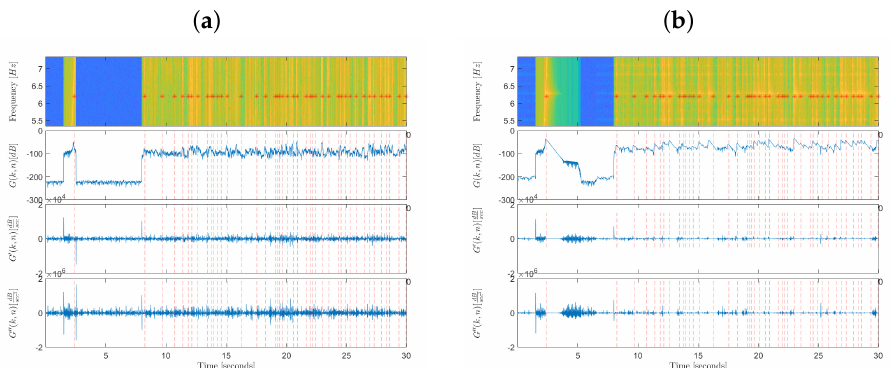
Figure 4. Comparison of spectrogram and history-buffer analysis features along time, between an input test speech signal and the resulting underdamped reinforced speech: ( a ) Original Signal; ( b ) Underdamped Reinforced Signal. The features are extracted for the magnitude of a specific frequency bin, which consists of multiple soft howling detections. The beginnings of the detected underdamped howling segments are marked by red asterisks on the spectrogram, and by vertical dashed lines on the feature